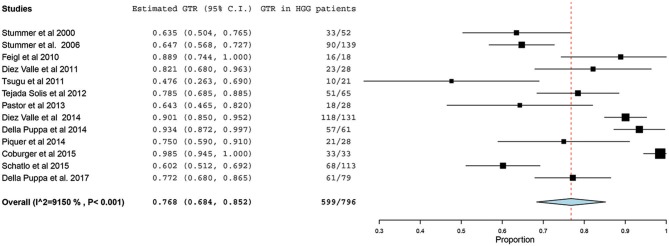
Forest plot graph representing the meta-analysis of gross total resection (GTR) rate (95% confidence interval [CI]) among patients with primary high-grade glioma (HGG) treated using 5-aminolevulinic acid–guided surgical resection. Used with permission from Barrow Neurological Institute, Phoenix, Arizona.